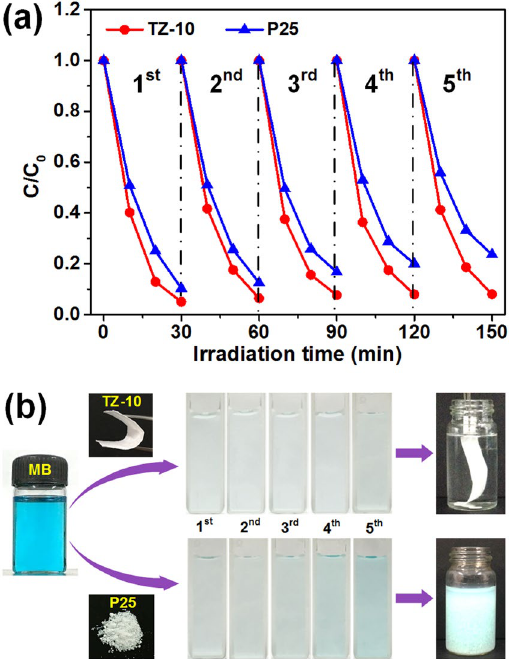
Figure 8. ( a ) Cycling photodegradation of MB over TZ-10 and TiO 2 under UV light irradiation. ( b ) Photographs of MB solutions which undergo UV light photodegradation for 5 cycles with TZ-10 and